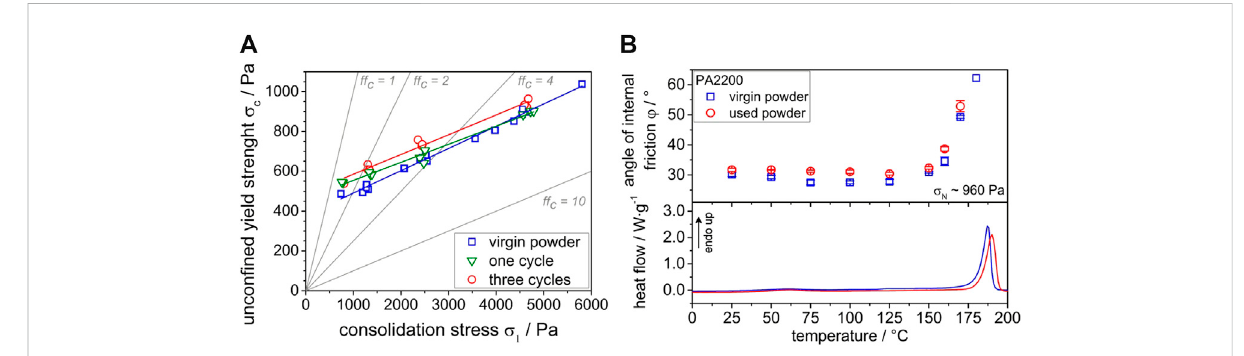
FIGURE 6 (A) Flow function for PA12 powders with varying aging states (one cycle implies 15.5 h of PBF-LB/P processing at 150 ° C building chamber temperature). (B) temperature-dependent angle of internal friction and thermograms for virgin and three times recycled PA12 powder (reprinted fromHesseetal.(2021),Towardsagenerallyapplicablemethodologyforthecharacterizationofparticlepropertiesrelevanttoprocessinginpowder bedfusionofpolymers — Fromsingle particletobulksolidbehavior.AdditiveManufacturing41,101,957,Copyright(2021),withpermissionfrom